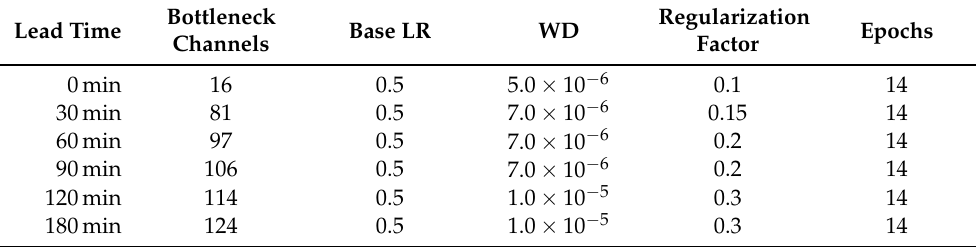
Table 4. Detailed training settings, depending on lead time and network